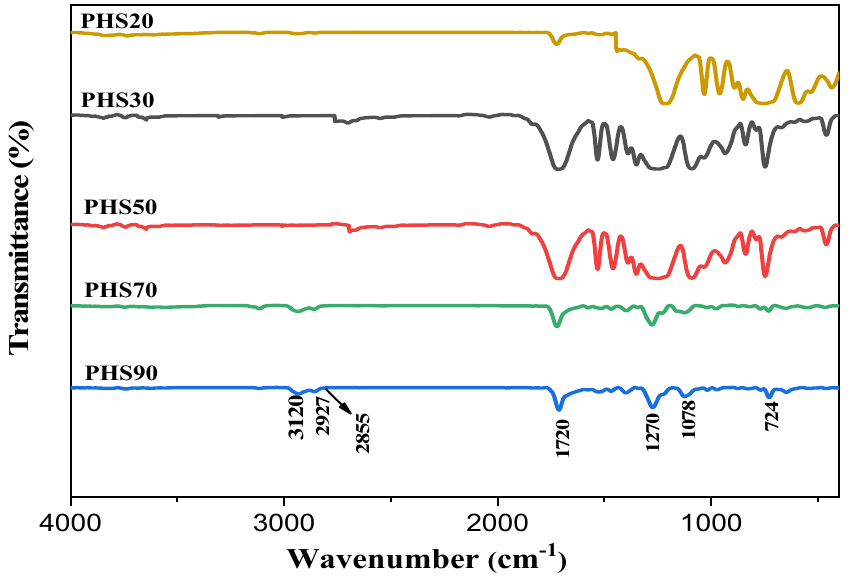
Figure 3. FTIR spectra for copolyesters PHS(20–90). Table 2. Characteristic FTIR stretching signals in the copolymers.